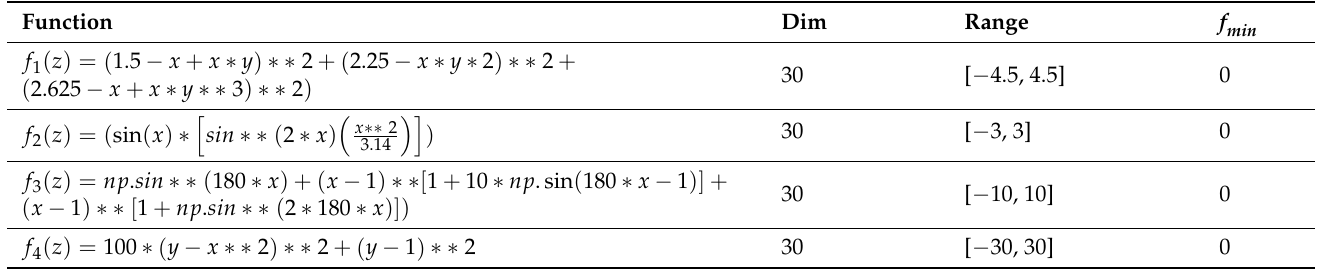
Table 3. List of benchmarking Figure 15. Best average fitness values for 100 abstract services.